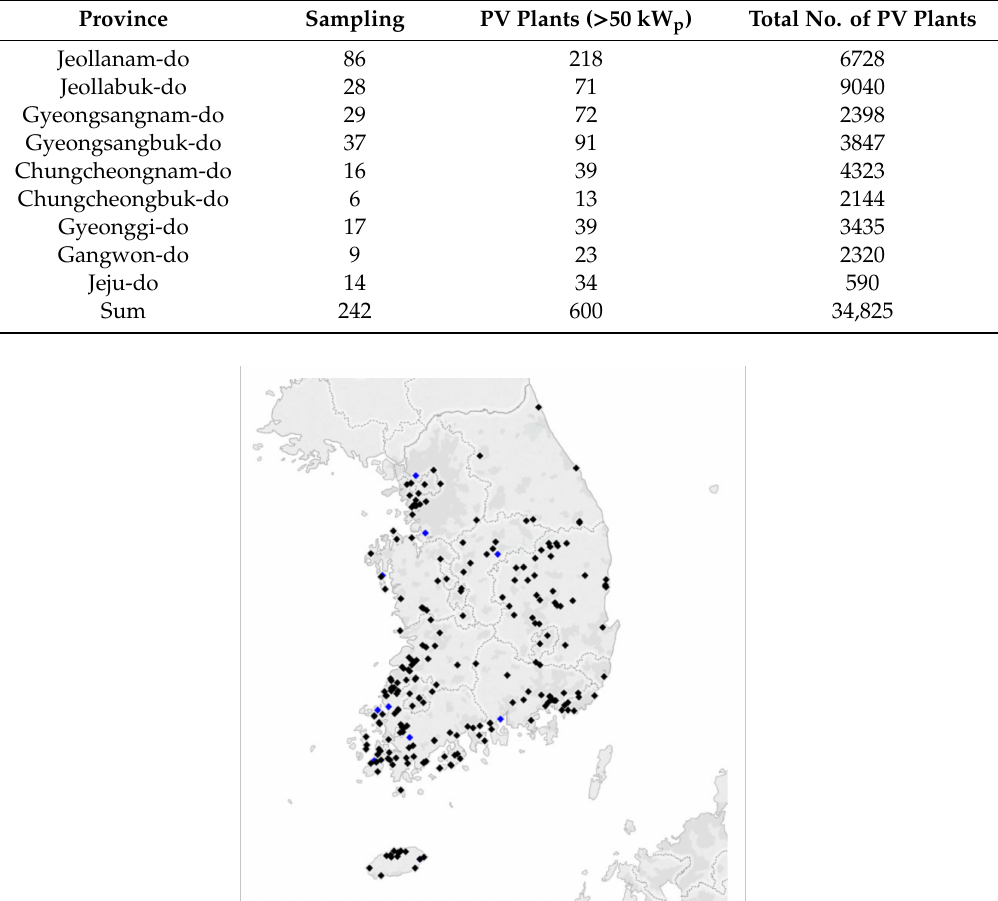
Table 1. Provincial distribution of the sample photovoltaic (PV) power plants.